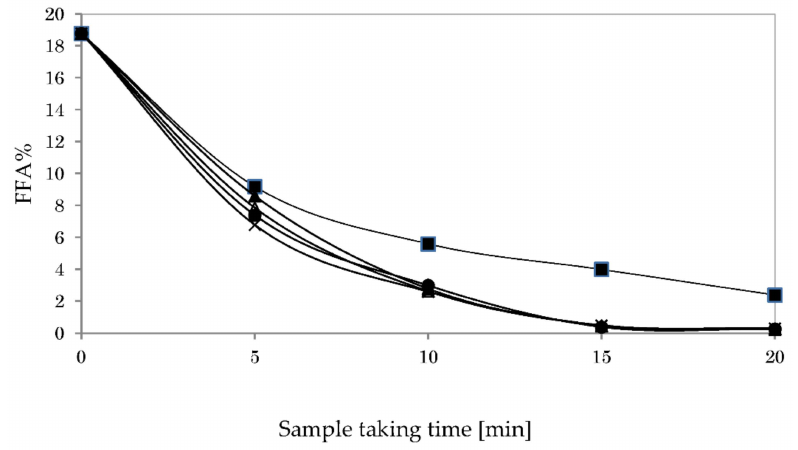
Figure 14. Impact of the stirring speed on glycerolysis reaction ( (cid:4) : 200 rpm, (cid:78) : 300 rpm, ∆ : 350 rpm, • : 400 rpm, × : 500 rpm), (Temperature: 200 ◦ C, Time: 30 min, Catalyst: 1 wt.% KOH, Co-solvent: 0.5 wt.% hexane, Oil-to-glycerol molar ratio: